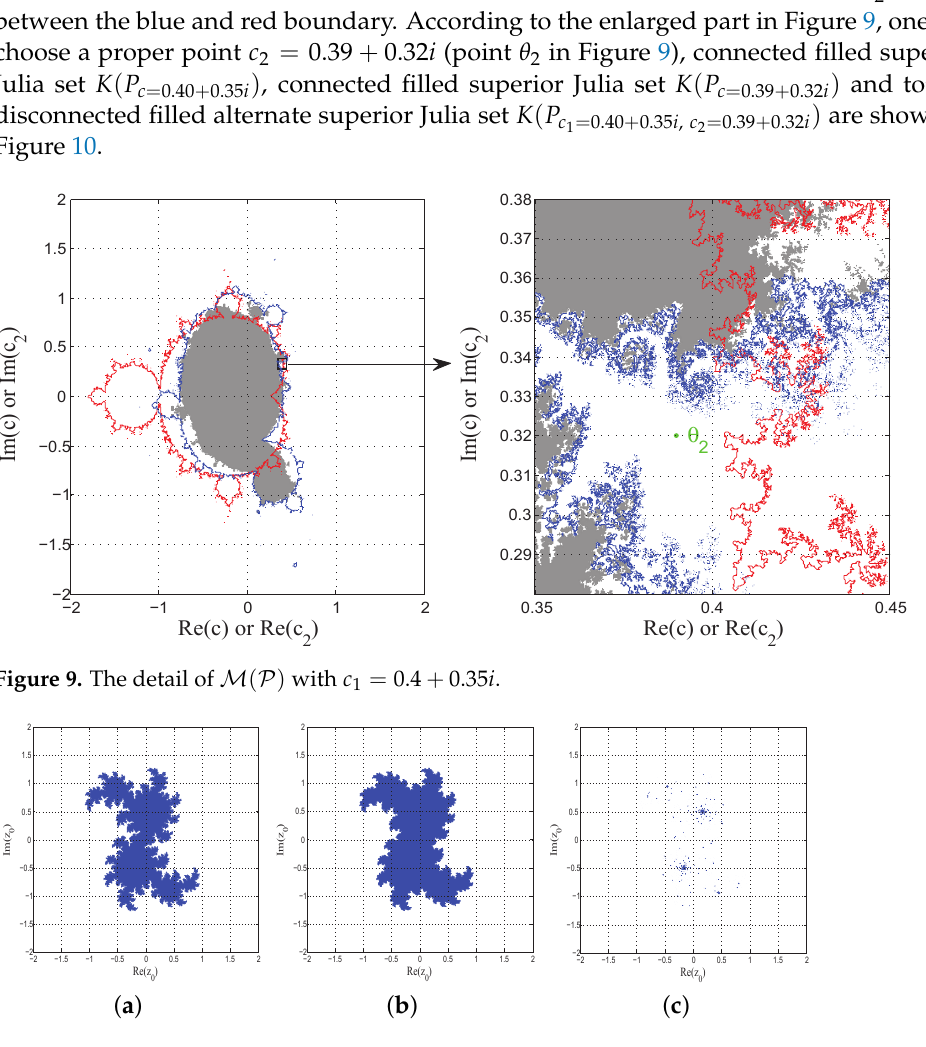
Figure 10. ( a ) K ( P c = 0.40 + 0.35 i ) ; ( b ) K ( P c = 0.39 + 0.32 i ) ; ( c ) K ( P c